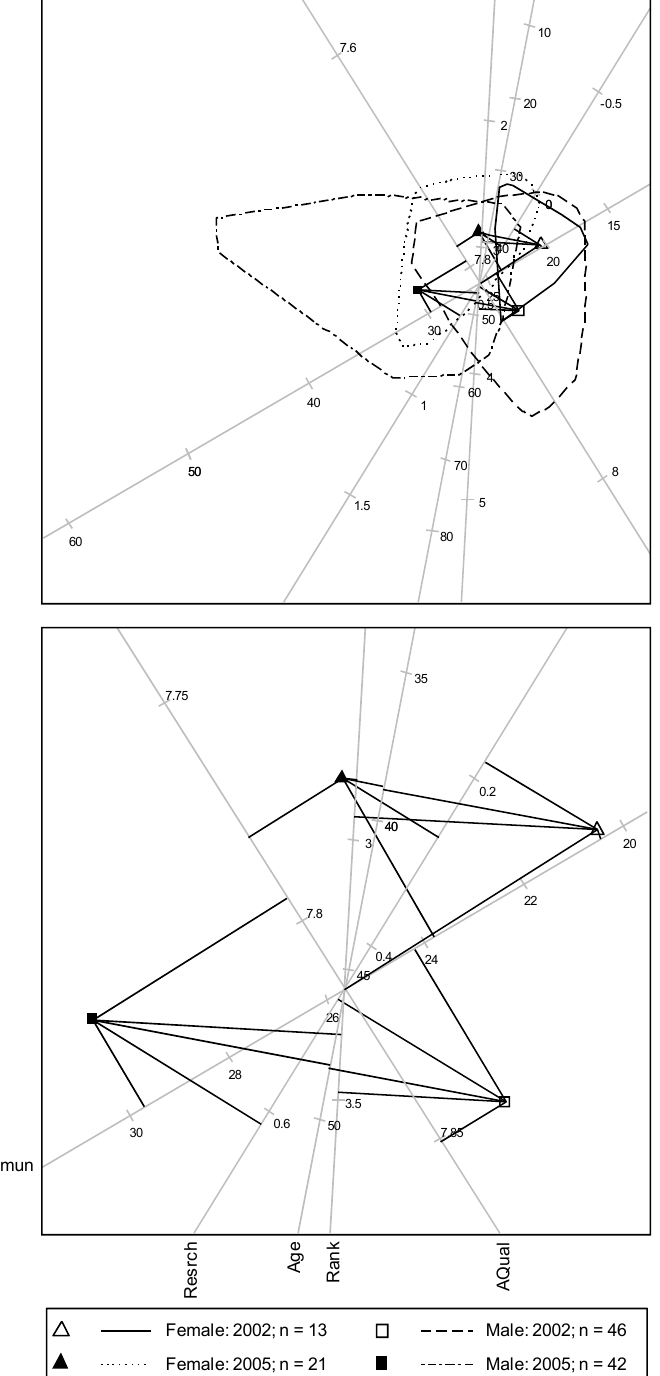
Figure 6: CVA biplot separating C1 staff in the Faculty of Agrisciences according to the 2002 Female, 2005 Female, 2002 Male and 2005 Male subgroups. Plotting of data points is suppressed. The upper panel shows the biplot overlaid with 90% bags. The bottom panel shows the group means on a large scale together with perpendicular lines from each group mean to the five axes for determining the biplot predictions of the different